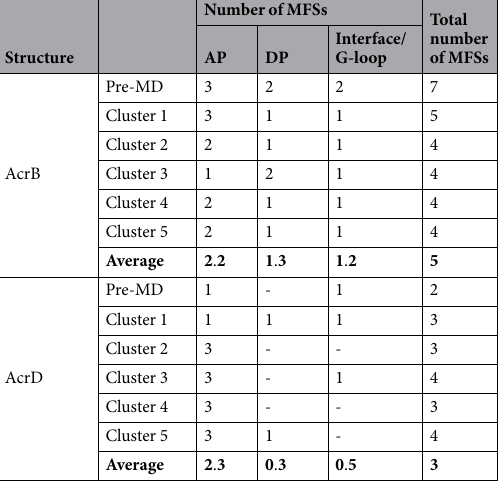
Table 5. The number of MFSs identified in the binding pockets of AcrB and AcrD before and during MD. See Table 3 for further